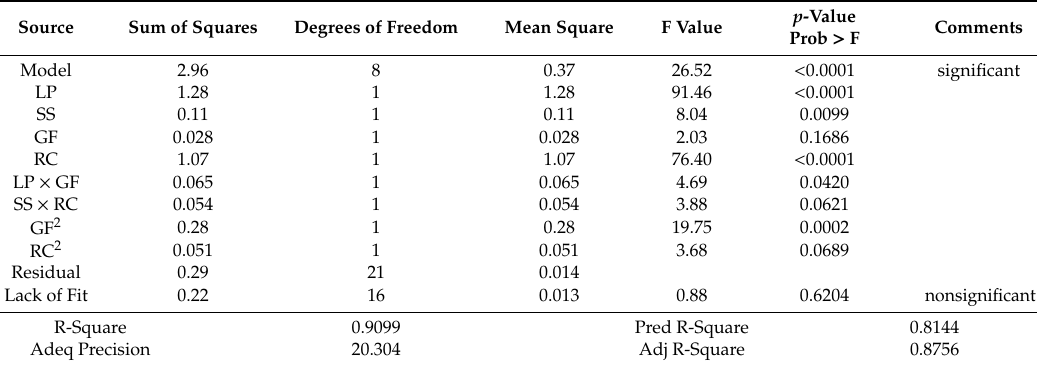
Table 5. Analysis of variance of clad height.